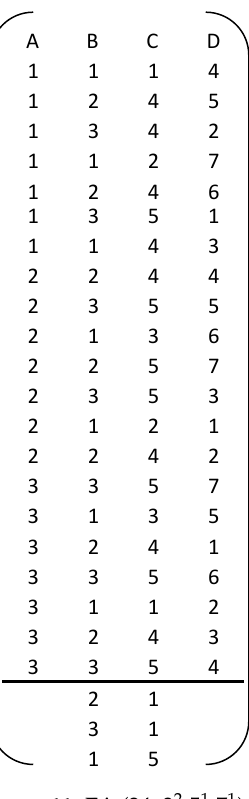
Figure 10. Breaking correlation between B and C.